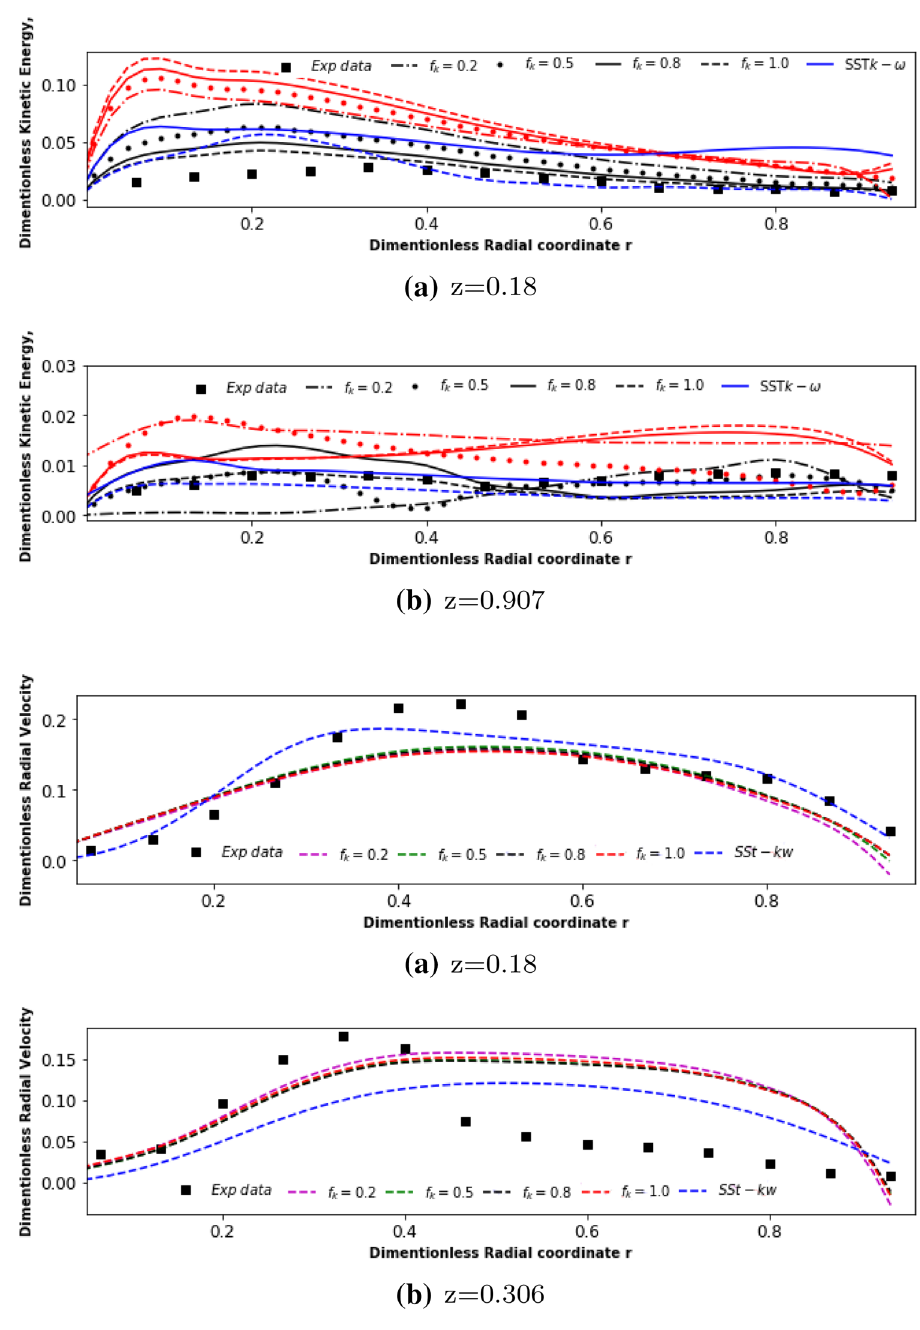
Fig. 5 Comparison between upwind and power-law scheme for PANS k u − 𝜖 u and SST k − 𝜔 model. PANS k u − 𝜖 u power-law —- , PANS k u − 𝜖 u